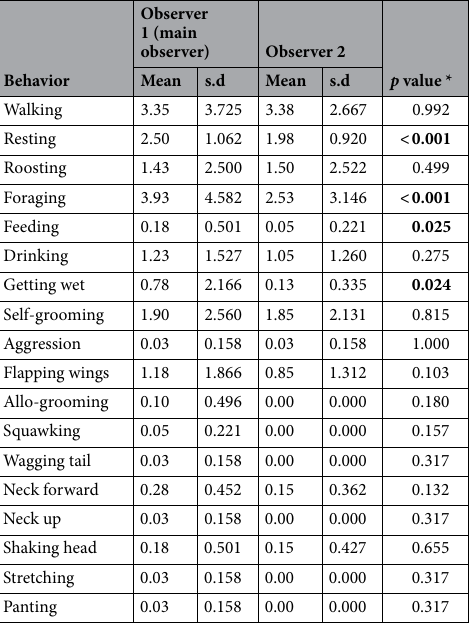
Table 1. Mean and standard deviation (s.d.) of the frequencies recorded by the two observers for each behavioral variable. Significant values are in bold. * Wilcoxon signed rank